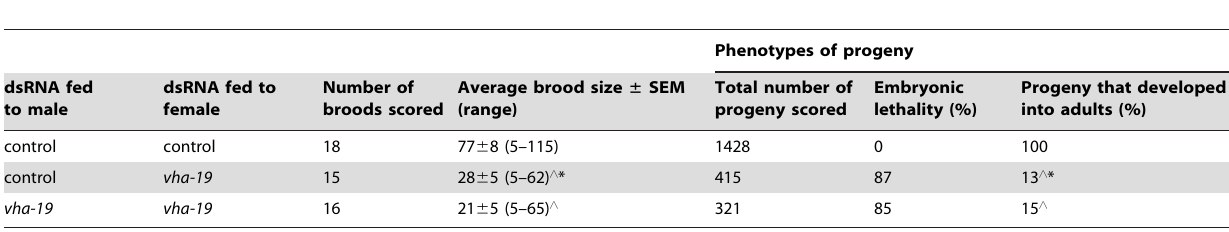
Table 3. The progeny produced by mating fog-2 male C. elegans with fog-2 female C. elegans fed on either control or vha-19